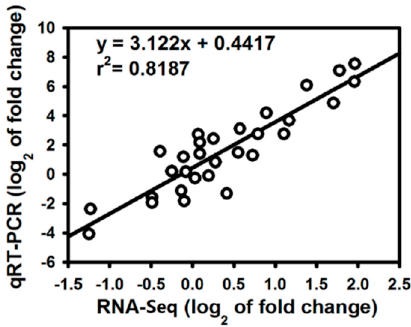
Figure 4. Coefficient analysis of gene expression levels obtained from RNA-Seq and qRT-PCR data. Log 2 fold change: log 2 fold-change in gene expression between Si-treated and non-Si-treated samples.